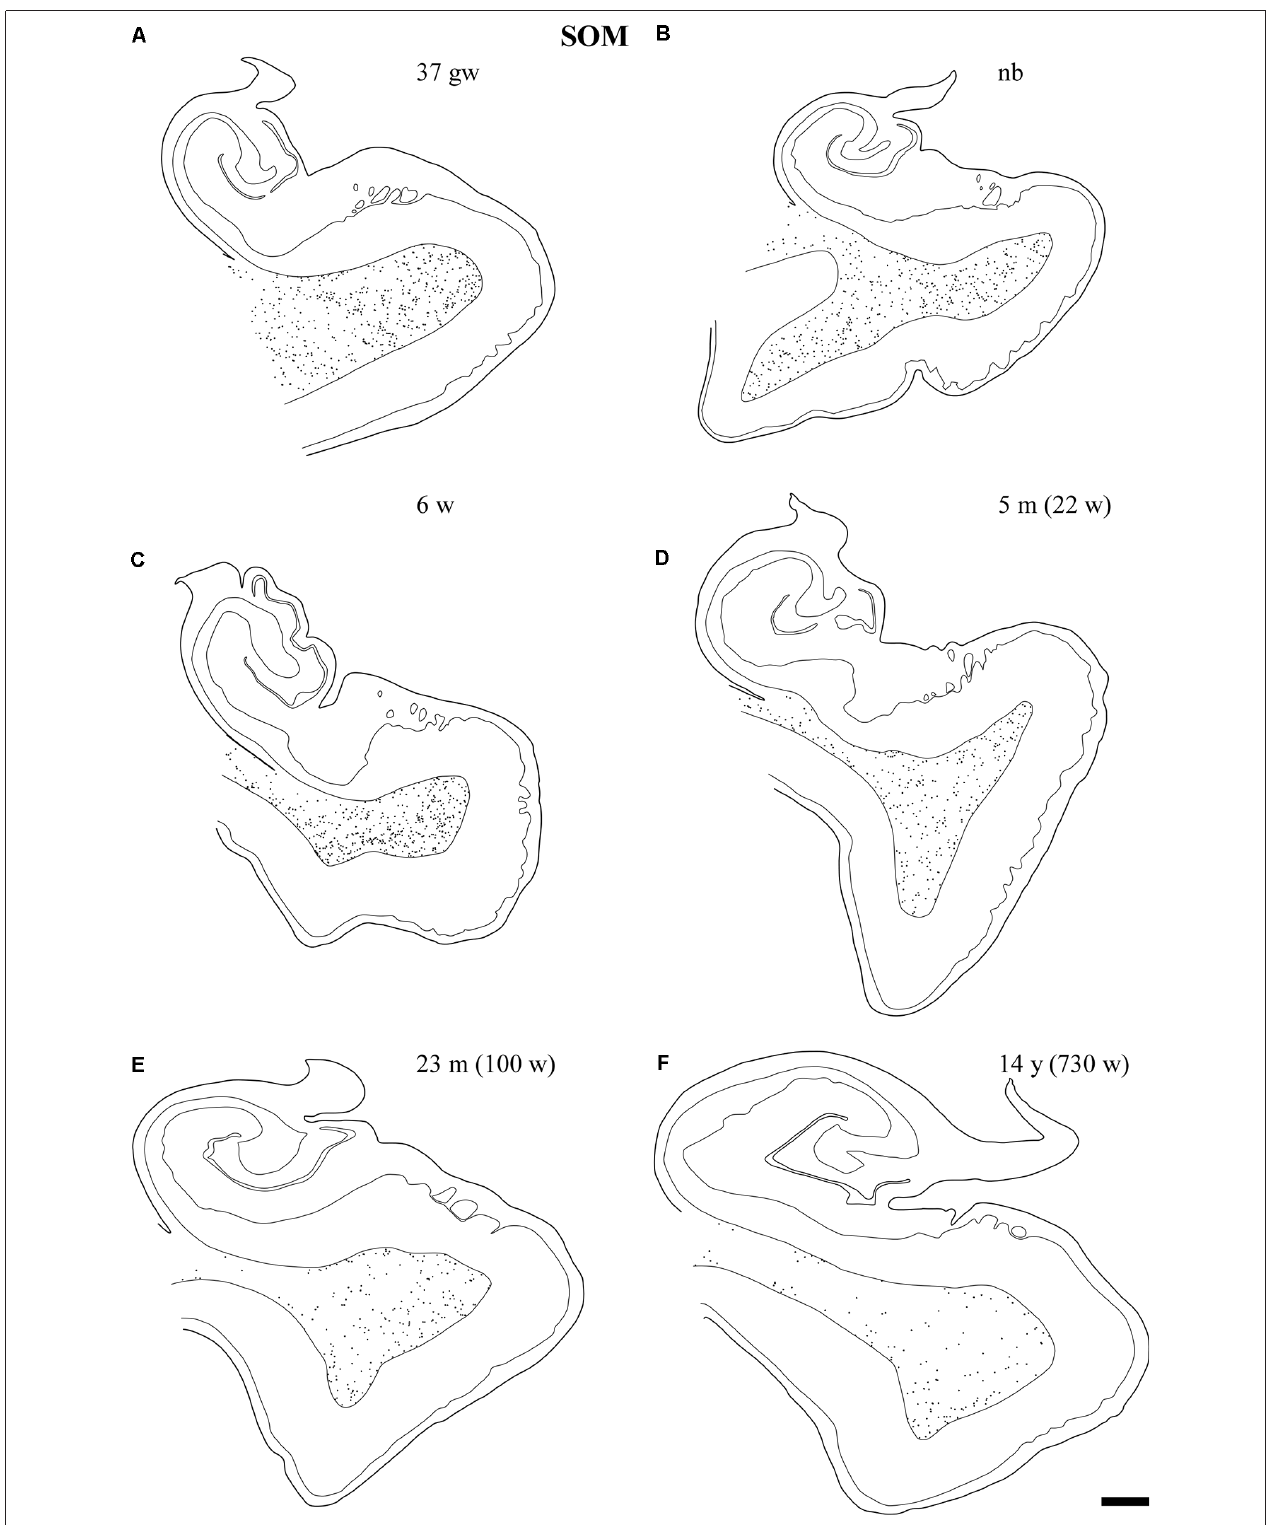
FIGURE 6 | Line drawings with representation of a series of sections of the angular bundle at midlevel in which SOM-28 neurons have been plotted. Only white matter neurons were charted. Panels (A,B) shows high density of SOM-28-immunolabeled neurons, which decrease by 23 months (E) and continues into 14 years (F) . Other conventions as in Figure 3 . Scale bar is 2